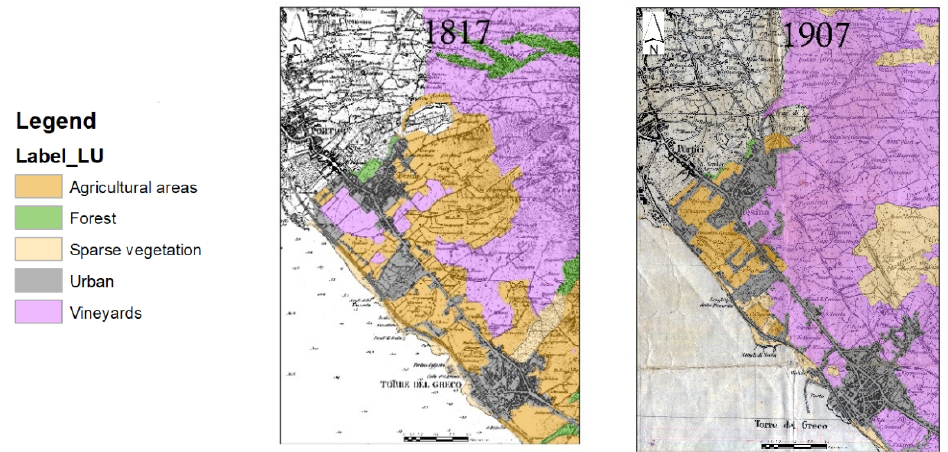
Figure 4. Detailed views of a portion of the original maps (1817-sheet 9 and 1907-sheet 184 II N.E. (Monte Vesuvio), respectively) and the corresponding raster classification of the same area. Table 1. Thematic generalization for the 2009 LU